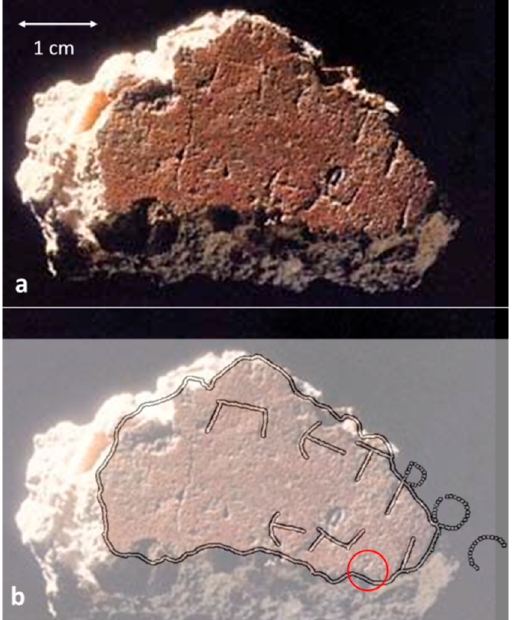
Figure 3. ( a ) Small fragment of plaster with the graffiti proving the presence of the Peter’s relics in the archeological site; ( b ) interpretation of the graffiti given by M. Guarducci. The red circle highlights a space between some letters or another possible partially visible incision, elements not considered in the interpretation proposed by M. Guarducci, as discussed in the main text.